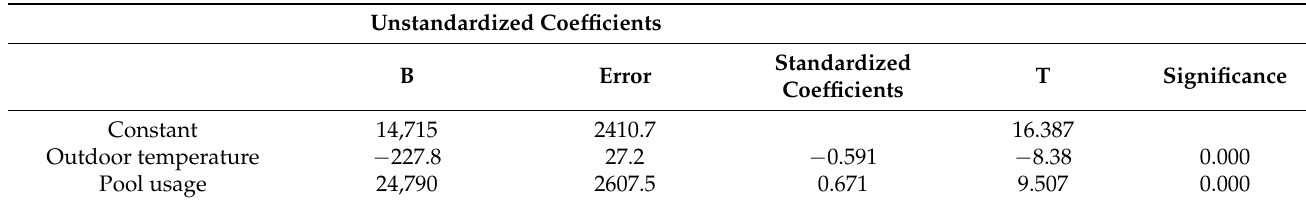
Table 2. Key outputs from the regression analysis.